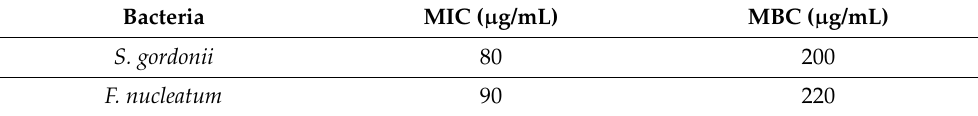
Table 3. The respective MIC and MBC values of KN-17 against S. gordonii and F. nucleatum .